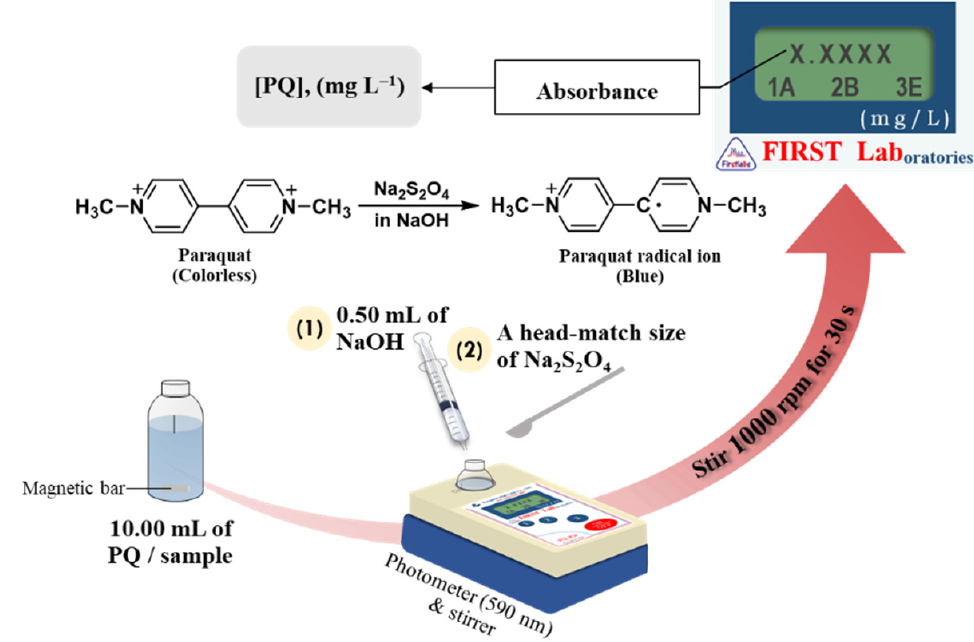
Figure 1. Schematic of all operational steps for paraquat test kit using handheld photometer.